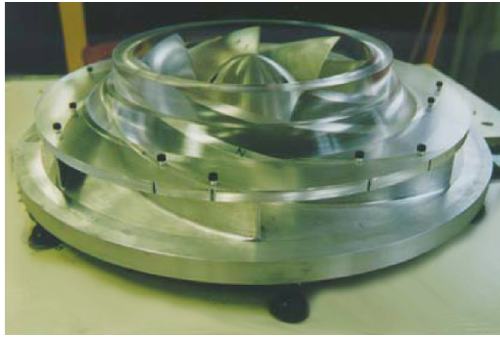
Figure 1: The SHF impeller.